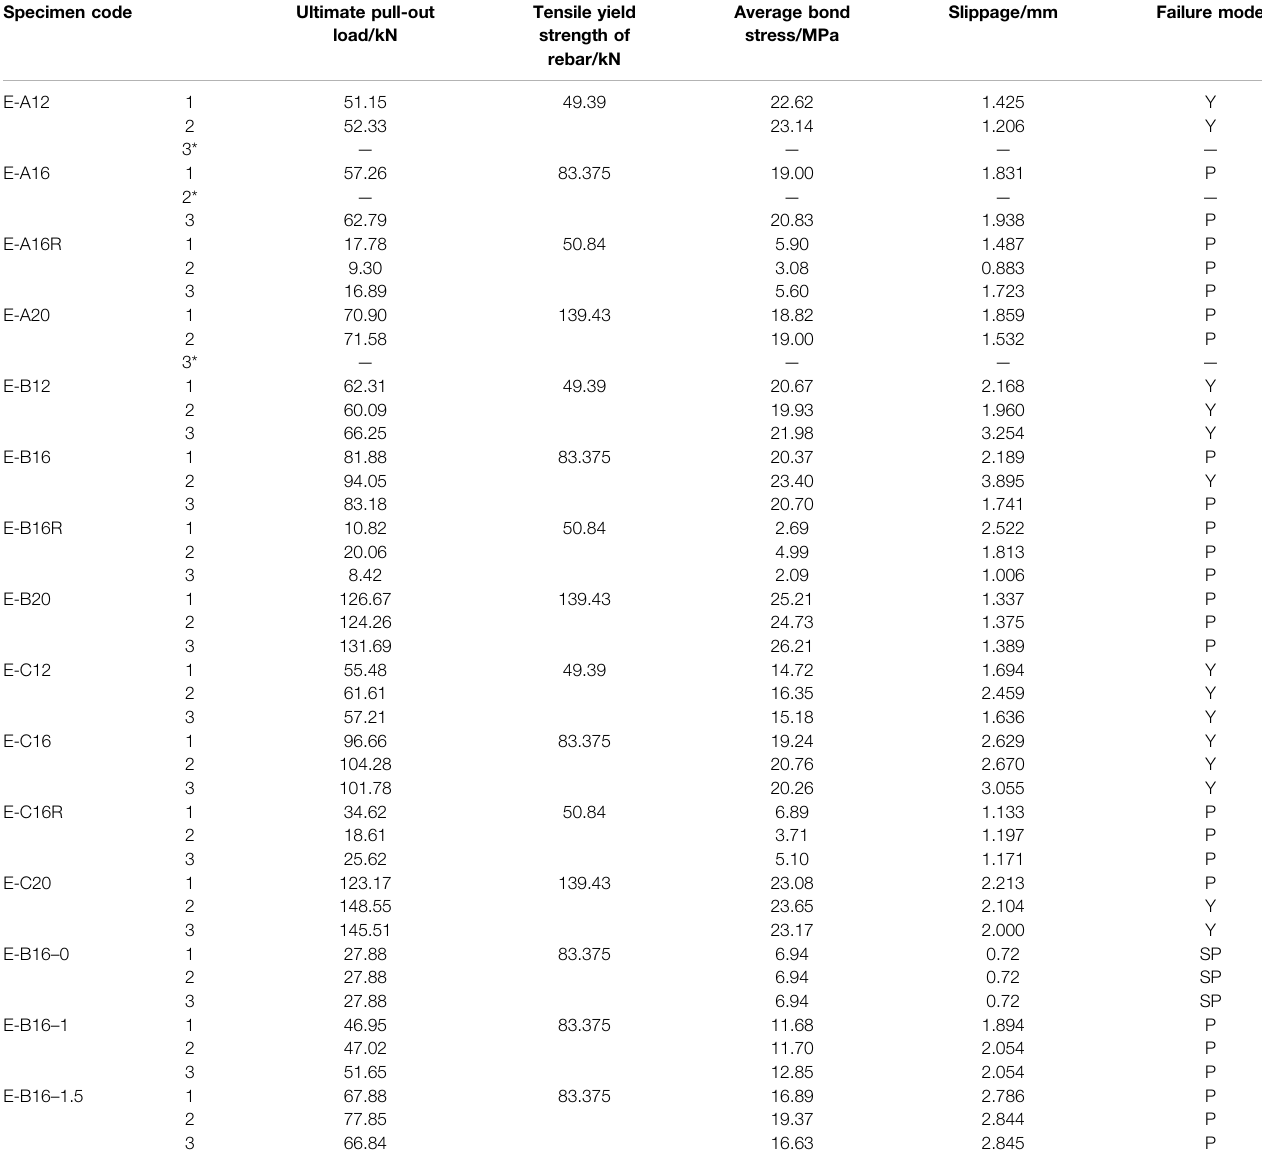
TABLE 5 | Summary of results from steel bar-ECC unidirectional pull-out tests. Specimen code Ultimate pull-out